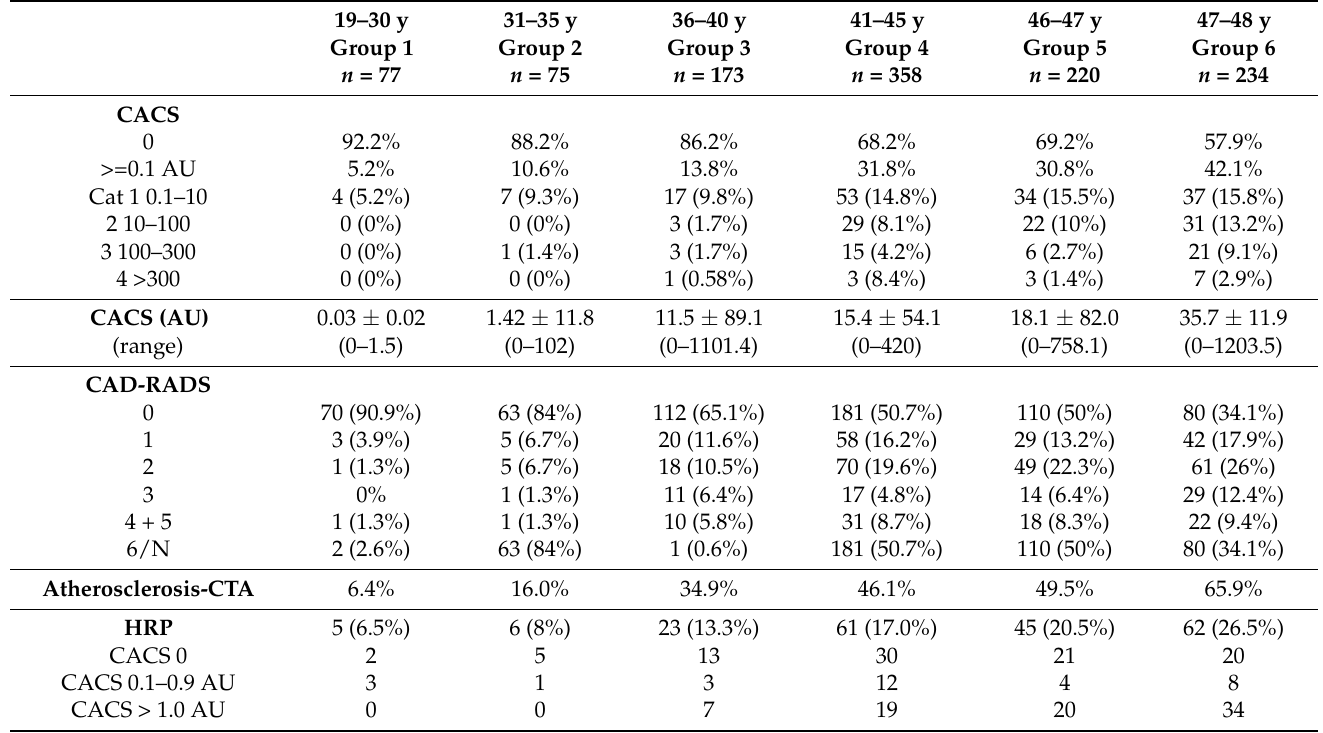
Table 2. Atherosclerosis in 6 age groups: coronary artery calcium score (ACS) and coronary CTA results.